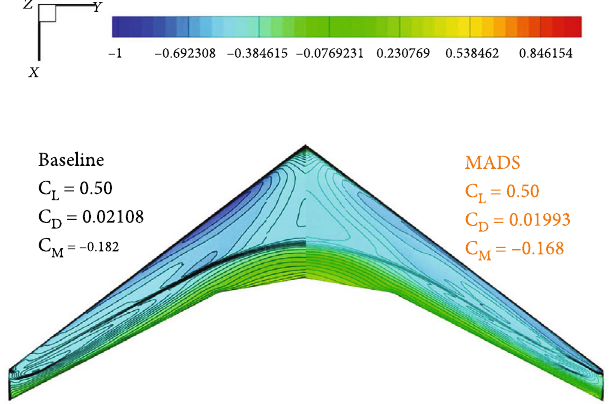
Figure 27: Pressure distributions of baseline and the